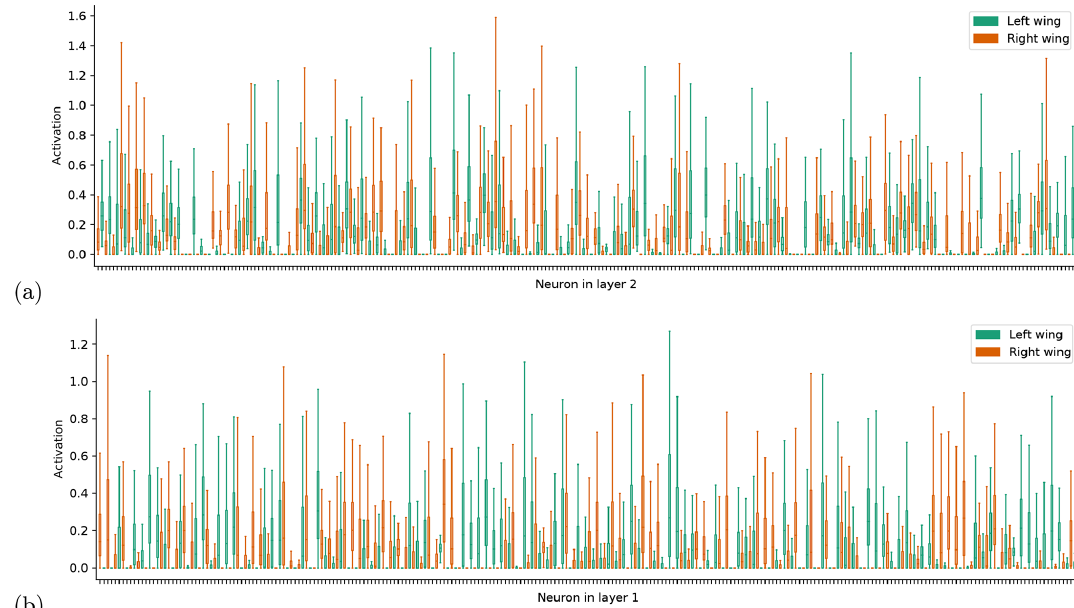
Figure C2. Same as Fig. 3b, e but showing all neurons without specific